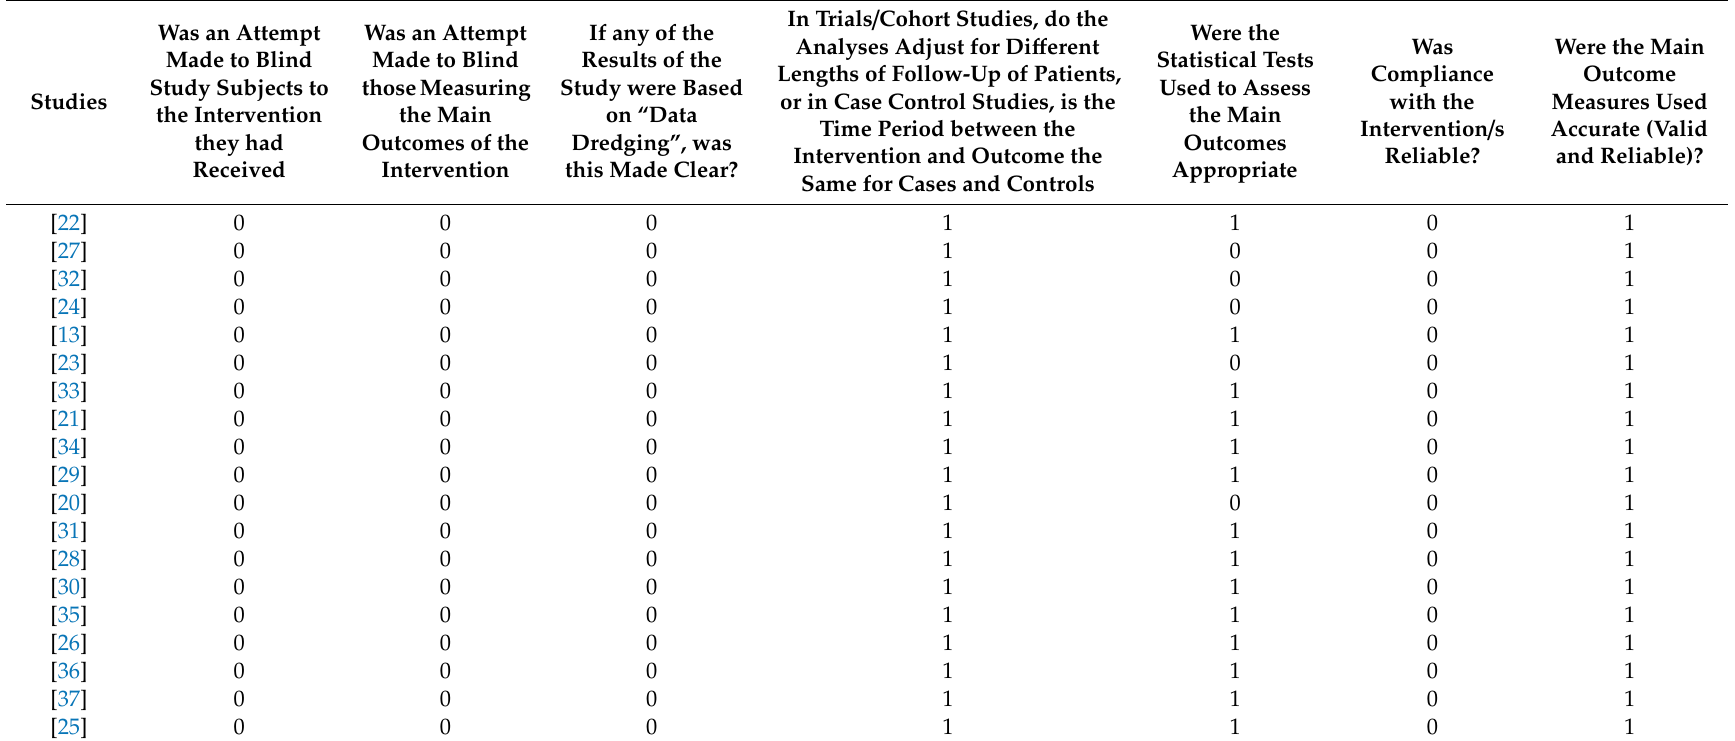
Table 5. Summary of the checklist for measuring internal validity (risk of